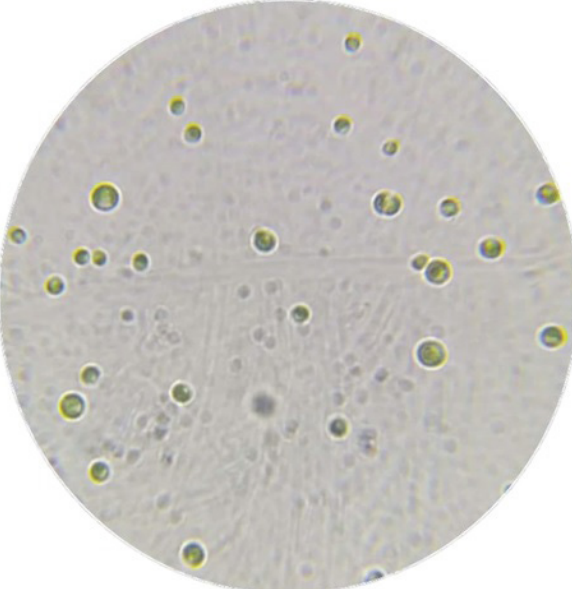
Figure 2: Microscopy picture of C. vulgaris.